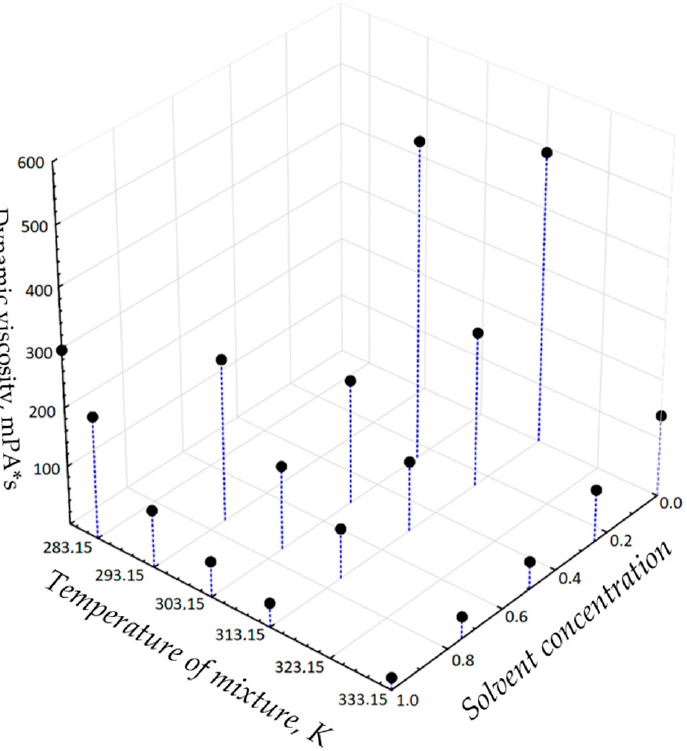
Figure 4. The distribution of values of dynamic viscosity coefficient obtained for Newtonian models